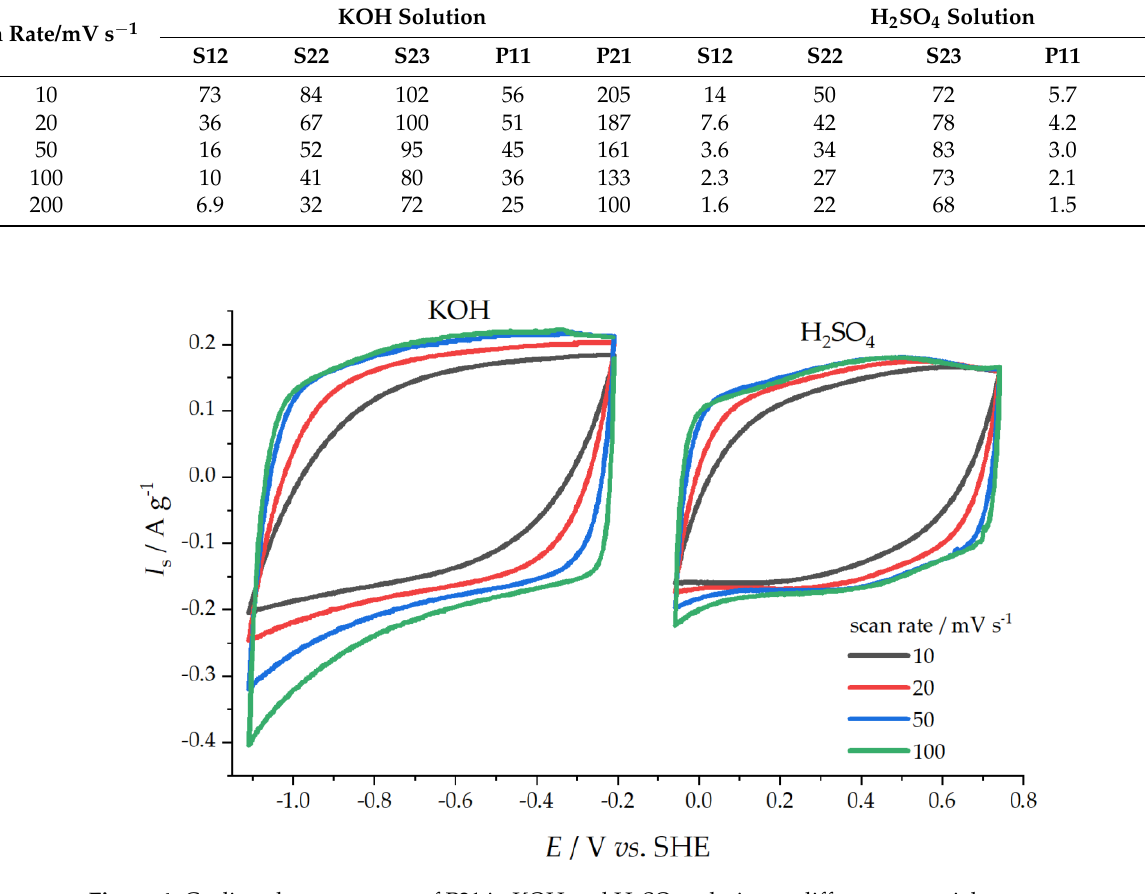
Figure 4. Cyclic voltammograms of P21 in KOH and H 2 SO 4 solution at different potential scan rates.